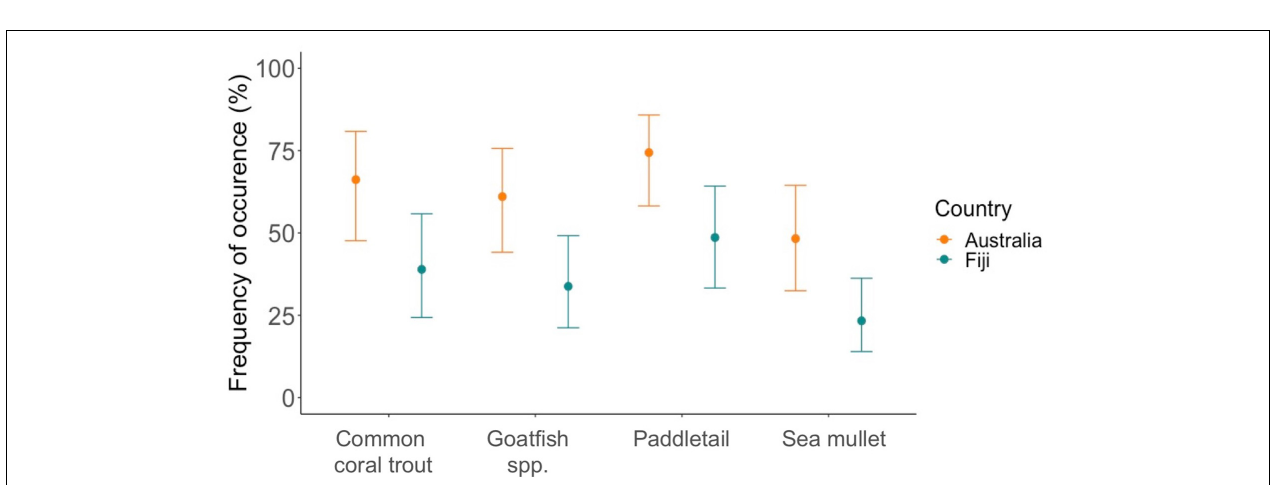
FIGURE 4 | Frequency of occurrence of plastic ingestion (FO). The graph shows the expected percentage of fish from each species that had at least one piece of microplastic present in their gastrointestinal tract based on a negative binomial GLM. The error bars show the lower and upper 95% confidence intervals. The blue points and lines represent fish purchased in Fiji and the orange points and lines represent those purchased in Australia. Refer to Table 1 for scientific species names, where goatfish is yellowspot goatfish for Fiji and bluestriped goatfish for Australia.